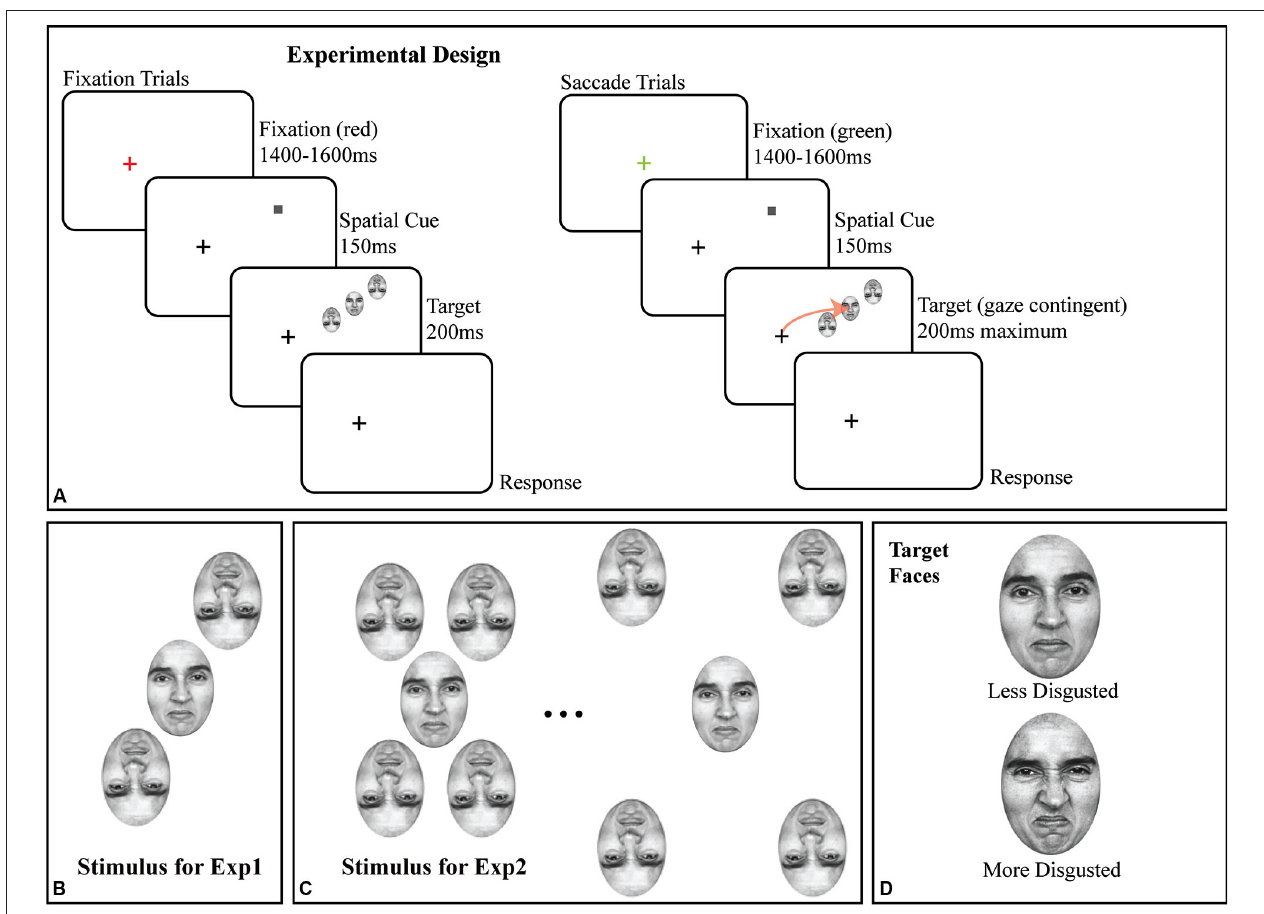
arrow in the saccade trial illustrates the subject’s saccade to the target face. (B) Crowded stimulus array used in Experiment 1 with two inverted flanking faces. (C) Illustration of crowded stimulus array as used in Experiment 2, showing two of five possible target-flanker spacings with four inverted flanking faces. (D) The less disgusted and more disgusted target faces used in both